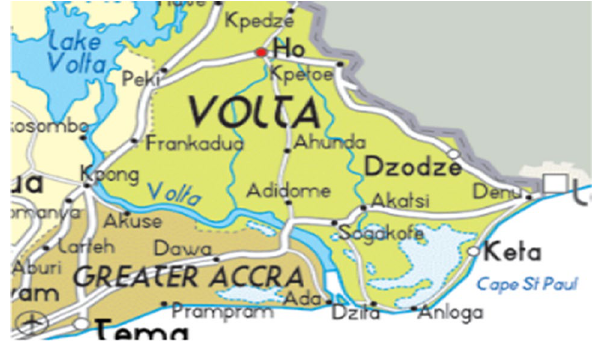
Fig. 1 Map of southeast part of Ghana showing the study area thus